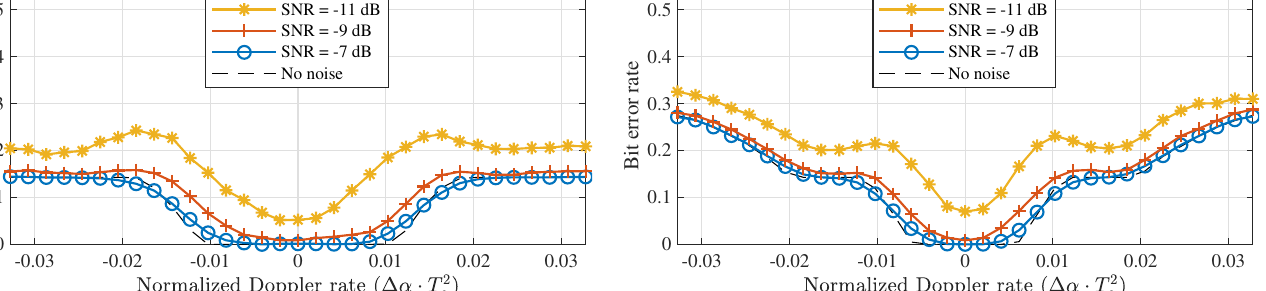
( a ) Data payload = 16 symbols, SF = 7. ( b ) Data payload = 32 symbols, SF = 7.